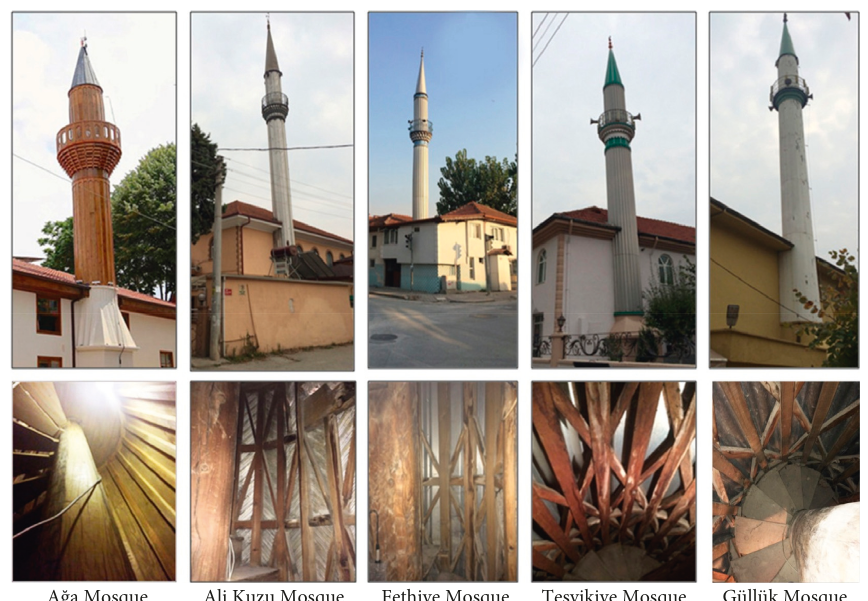
Figure 2: The studied mosque minarets. Table 1: The geometric properties and construction techniques of the Tes¸vikiye Mosque minaret. Construction techniques and the dimensions of the Body Upper body Spire circular outer wall (cm)